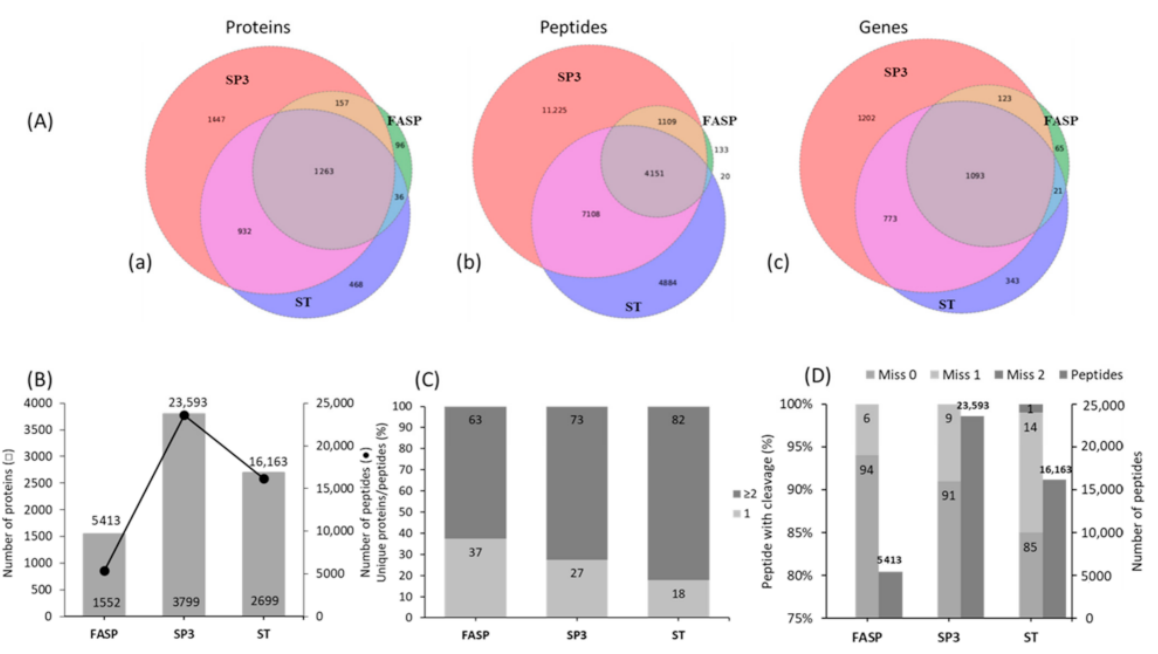
Figure 2. Comparison of protein and peptides numbers identified in filter-aided sample preparation (FASP), single-pot solid-phase-enhanced sample preparation (SP3), and stop-and-go-extraction tips (STAGETips, ST) based protein sample preparation workflows. ( A ) Venn diagram showing the overlap of proteins ( a ), peptides ( b ), and annotated genes ( c ); total number of identified proteins and peptides ( B ); Percentage of unique peptides among proteins identified with 1 and ≥ 2 unique peptides ( C ); Percentage of identified peptides containing zero, one, and two missed tryptic cleavages ( D ) for each workflow combined from three biological replicates ( n =